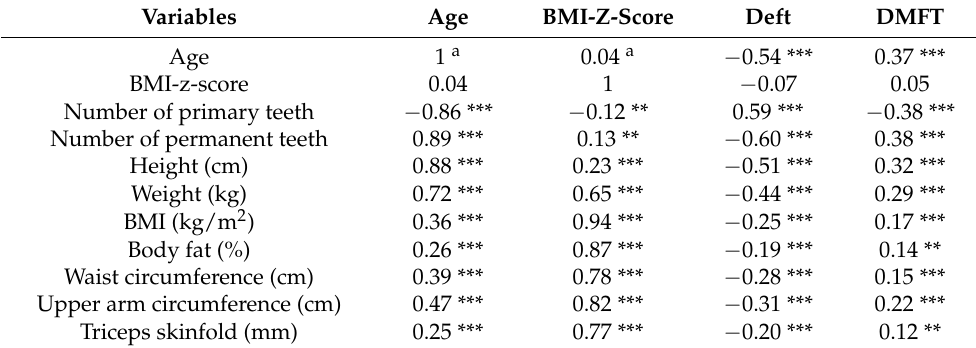
Table 3. Correlations between anthropometric measures, age, number of teeth, and caries scores. Variables